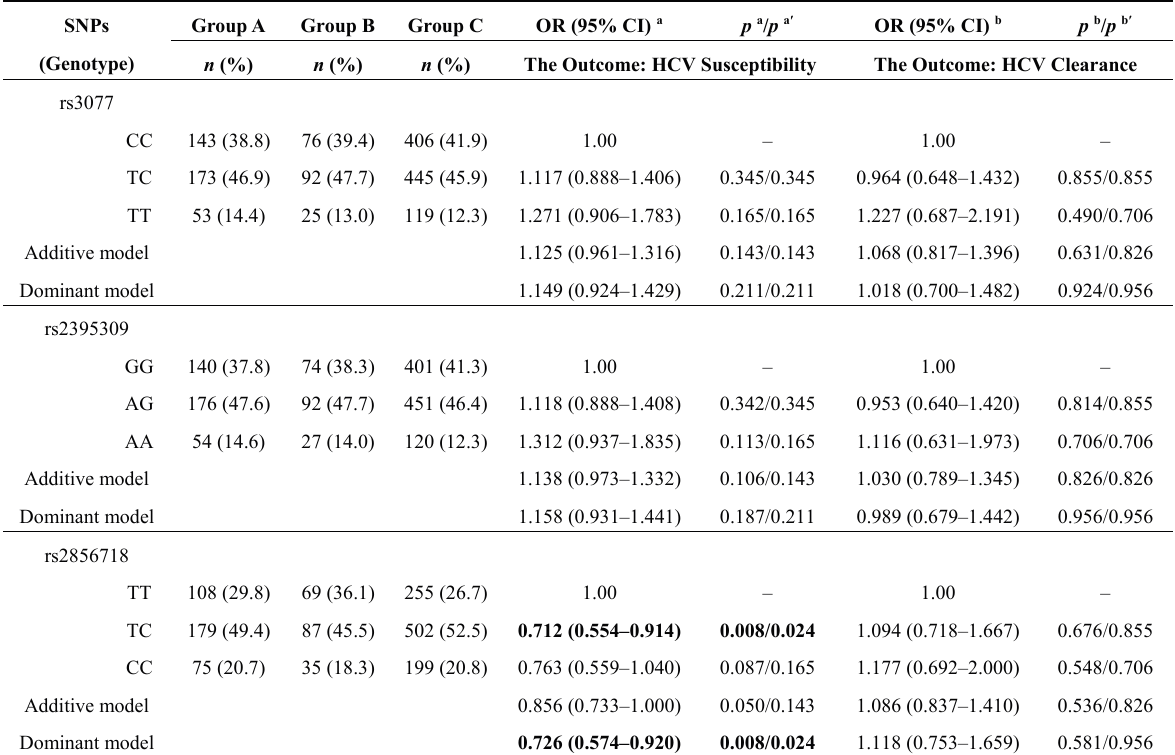
Table 2. Distributions of HLA class II genotypes among persistent infection, spontaneous clearance and control